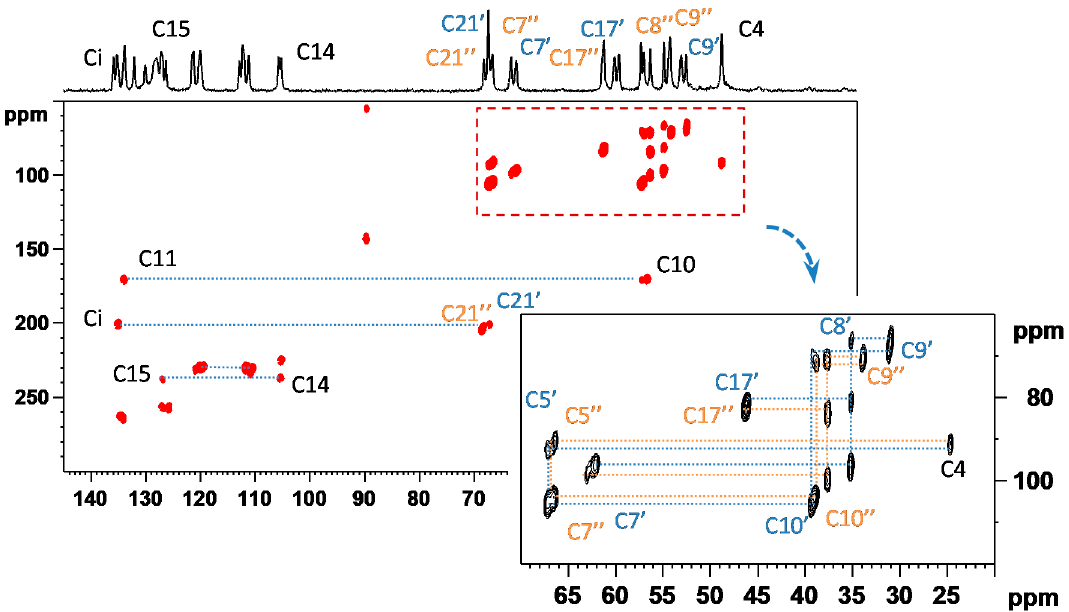
Figure 4. The experimentally recorded 2D 13 C– 13 C CP-INADEQUATE NMR spectrum of MII . In the inset, the connectivity of individual carbon chains in two symmetry-independent molecules is indicated for the aliphatic region. The upper projection is provided by the 1D 13 C CP/MAS NMR spectrum. The total experimental time of data acquisition was eight days. For full-size spectra see Supporting Information (SI-Experimental details).